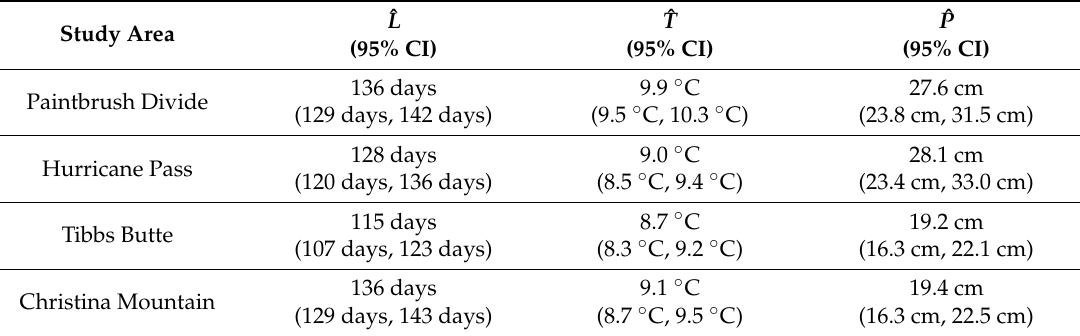
Table 6. Mesoclimate parameter estimates.